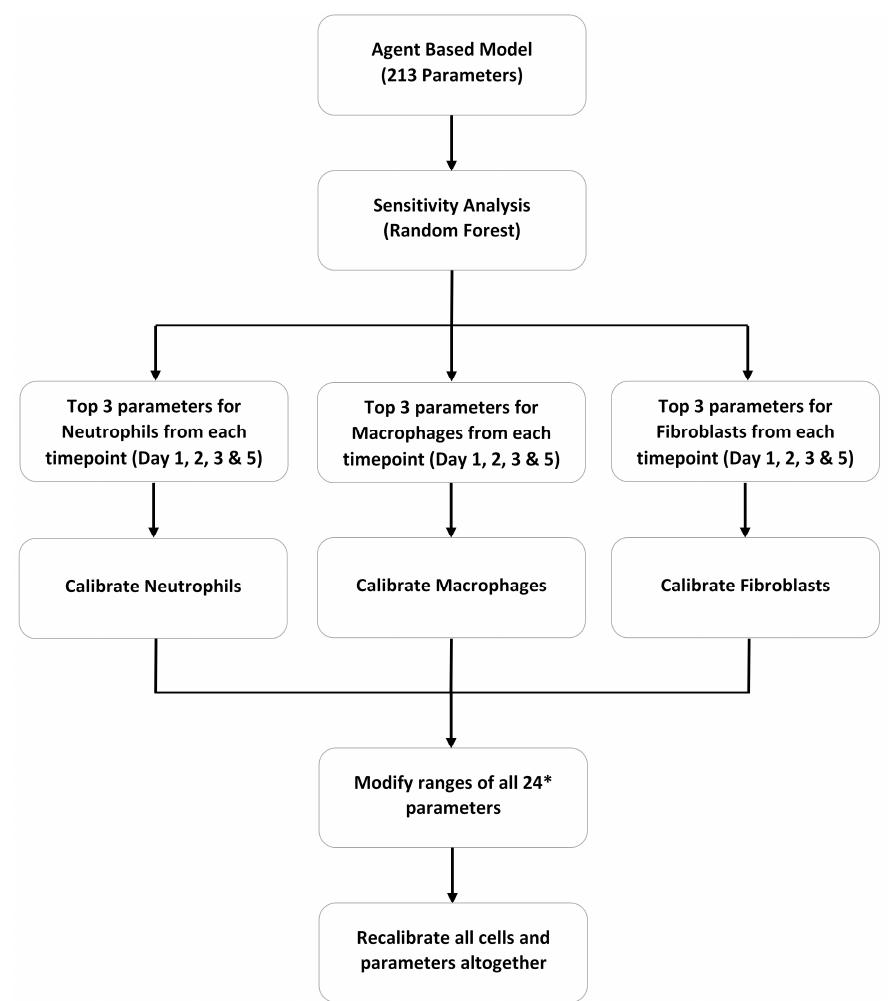
Figure 1. Workflow of VF-ABM Calibration. A total of 36 top parameters were ranked for each cell type at each time point. Twelve of them were overlapped across conditions. As a result, a total of 24 unique parameters were used for calibration.